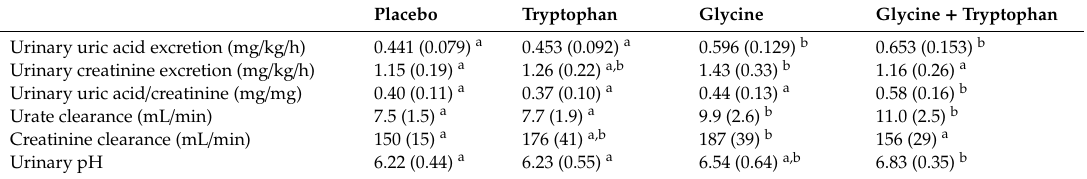
Table 4. Comparison of urinary parameters in the placebo and amino acid supplementation groups.